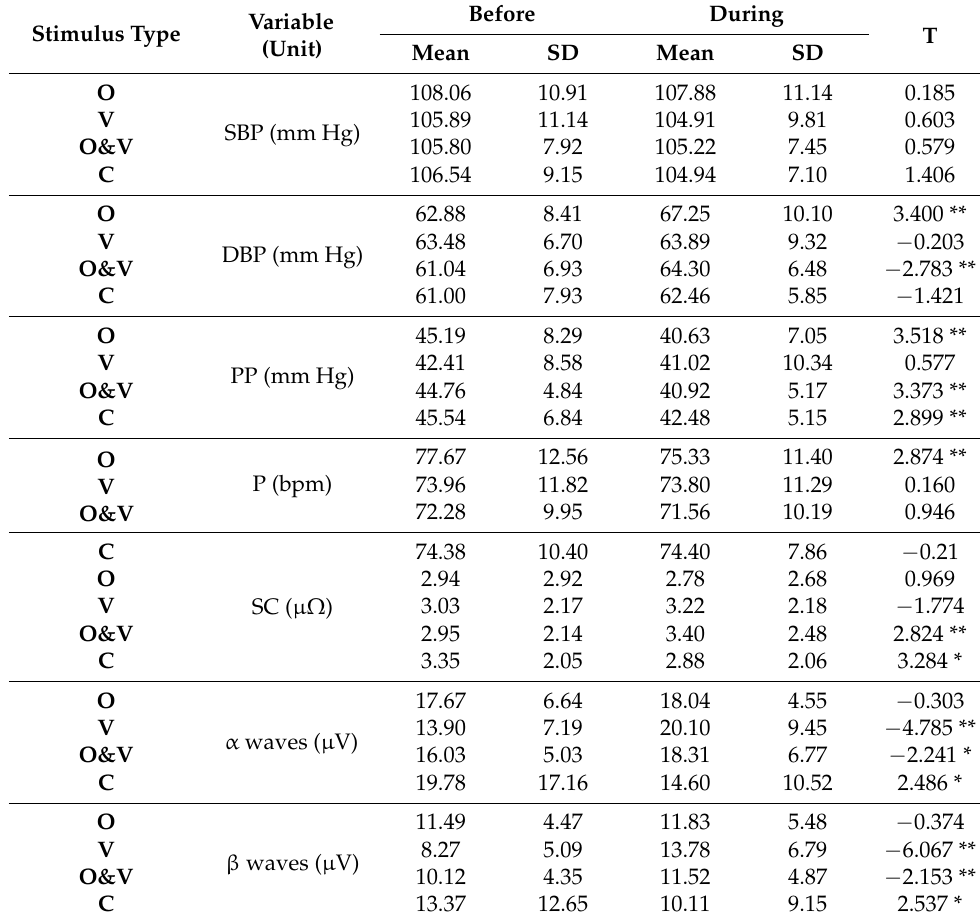
Table 1. Changes in physiological indexes before and during olfactory, visual and olfactory– visual